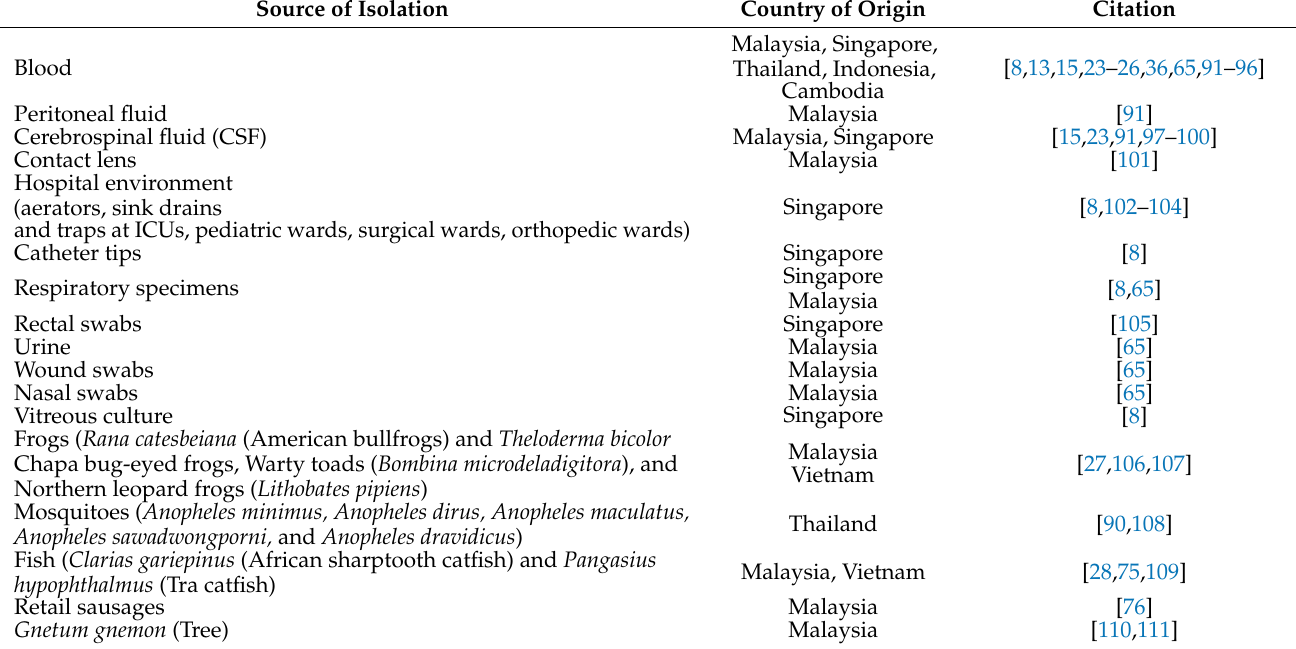
Table 1. Various sources of isolation of Elizabethkingia spp. in Southeast